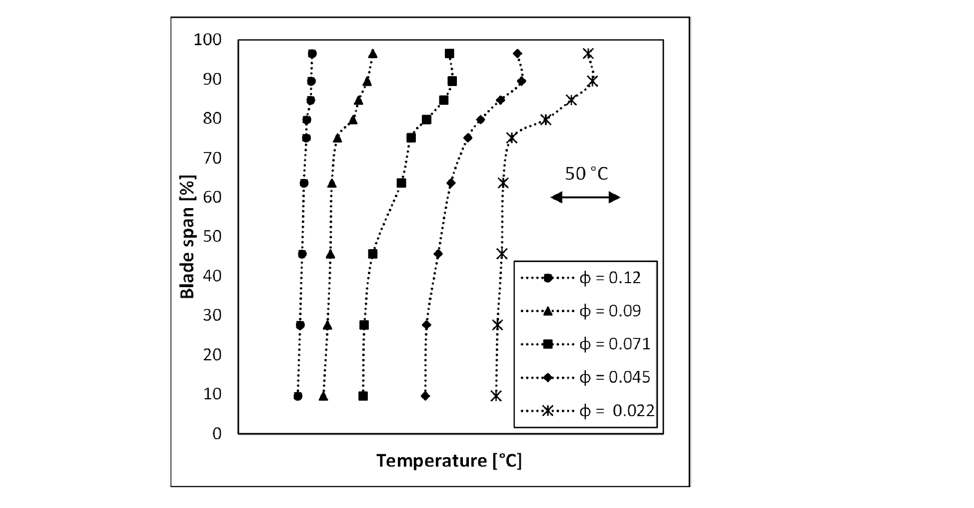
Figure 5. Measured temperature downstream of the LSMB. Temperature values are not shown for confidentiality reasons.